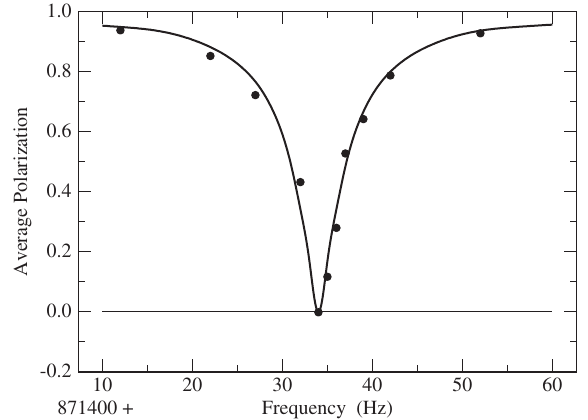
FIG. 22. Data and measurements with an uncooled beam for the average polarization in the vicinity of the resonance as a function of the rf-solenoid frequency.